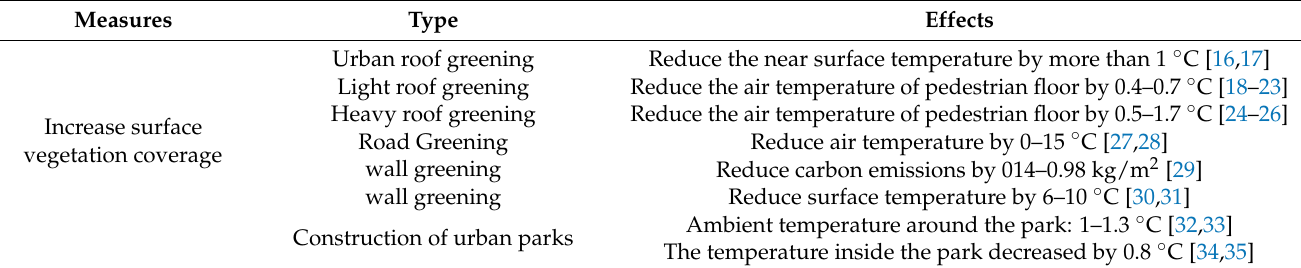
Table 1. Cooling effect of different types of